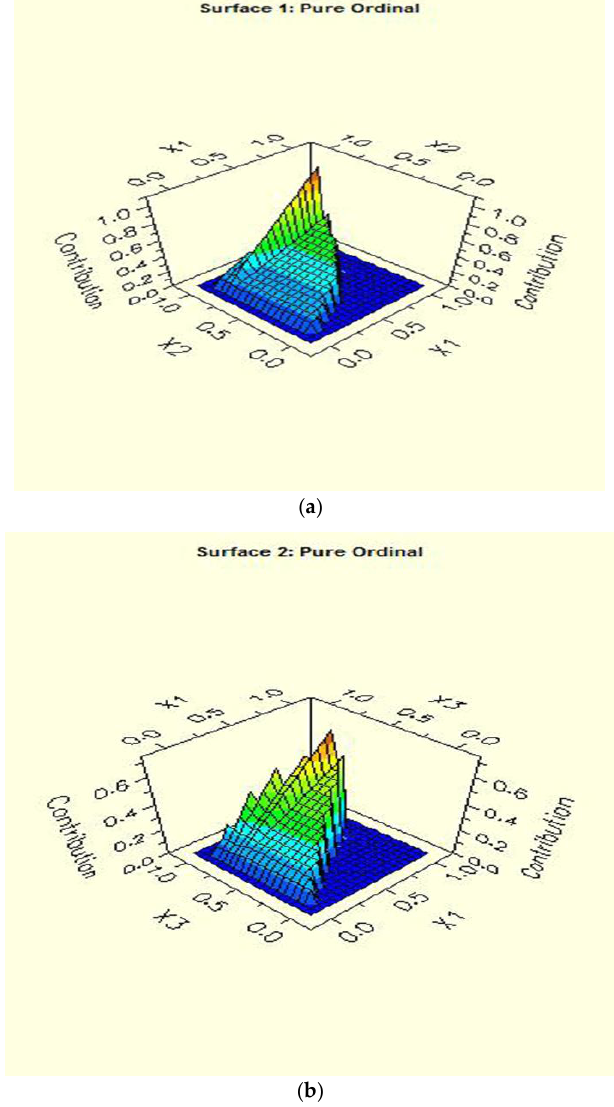
Figure 4. ( a ) Contribution to total cost y of the second order term of the variables design treatment capacity ( x 1 ) and removal efficiency of chemical oxygen demand ( x 2 ). ( b ) Contribution to total cost y of the second order term of the variables design treatment capacity ( x 1 ) and removal efficiency of ammonia nitrogen ( x 3 ).